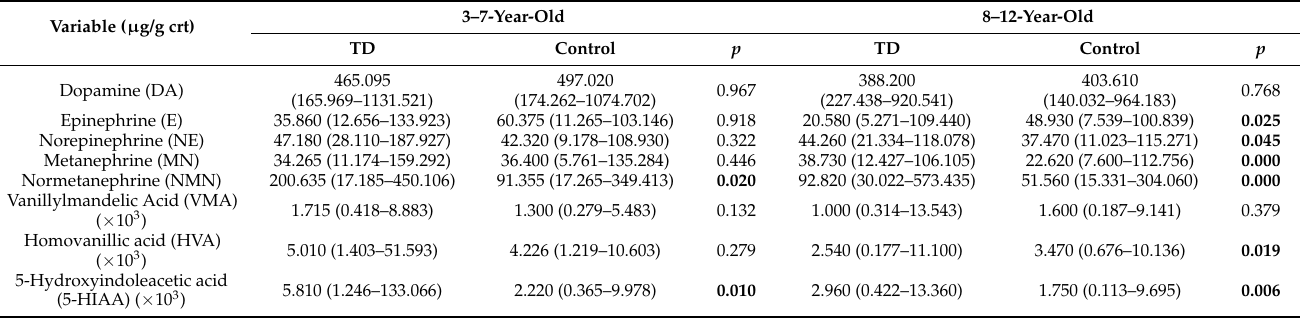
Table 3. Neurotransmitter levels in urine in patients in the TD and control